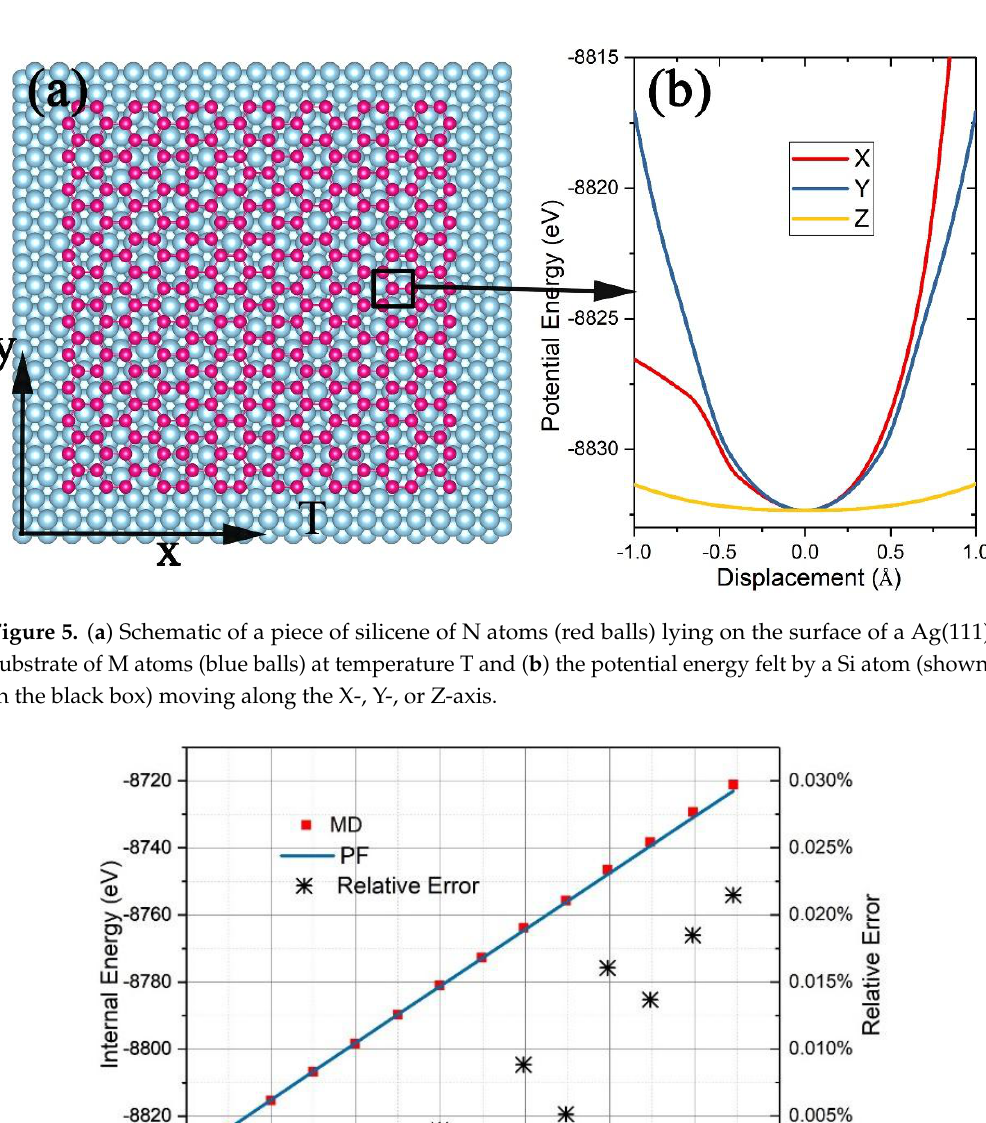
| E − E | × 100% (black stars) are characterized at the PF MD | E | MD × 100% (black stars) are characterized at ∣𝑬 𝑴𝑫 ∣